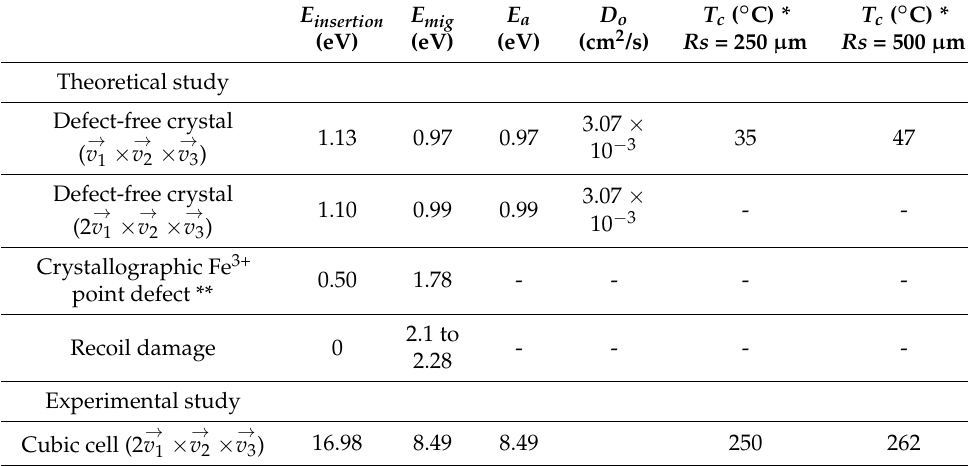
Figure 3. Crystallographic Fe 3+ point defect in the (2 𝑣 (cid:2869) (cid:4652)(cid:4652)(cid:4652)(cid:4652)⃗ × 𝑣 (cid:2870) (cid:4652)(cid:4652)(cid:4652)(cid:4652)⃗ × 𝑣 (cid:2871) (cid:4652)(cid:4652)(cid:4652)(cid:4652)⃗ ) cell. ( A ) view of the NEB migration pathway. ( B ) Evolution of the He energy between the interstitial site 16c and the vacancy site, passing though the transition state (TS). Table 2. Theoretical He diffusion data for